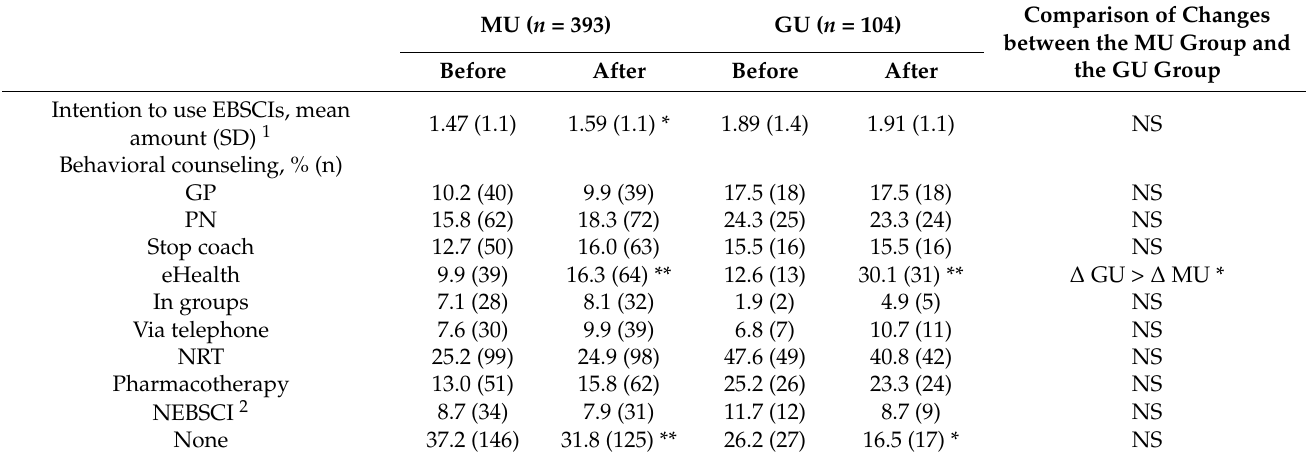
Table 5. Comparison of the intention to use EBSCIs measured before and after reviewing the DA. MU ( n = 393) GU ( n = 104) Comparison of Changes between the MU Group